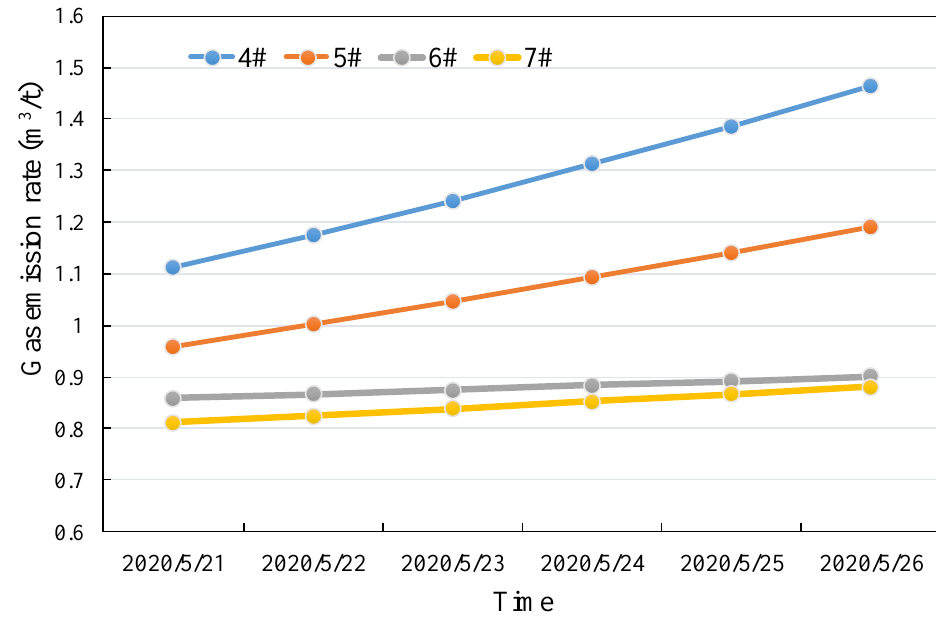
Figure 5. Analysis of gas prediction data in intake and return air roadway of working face.